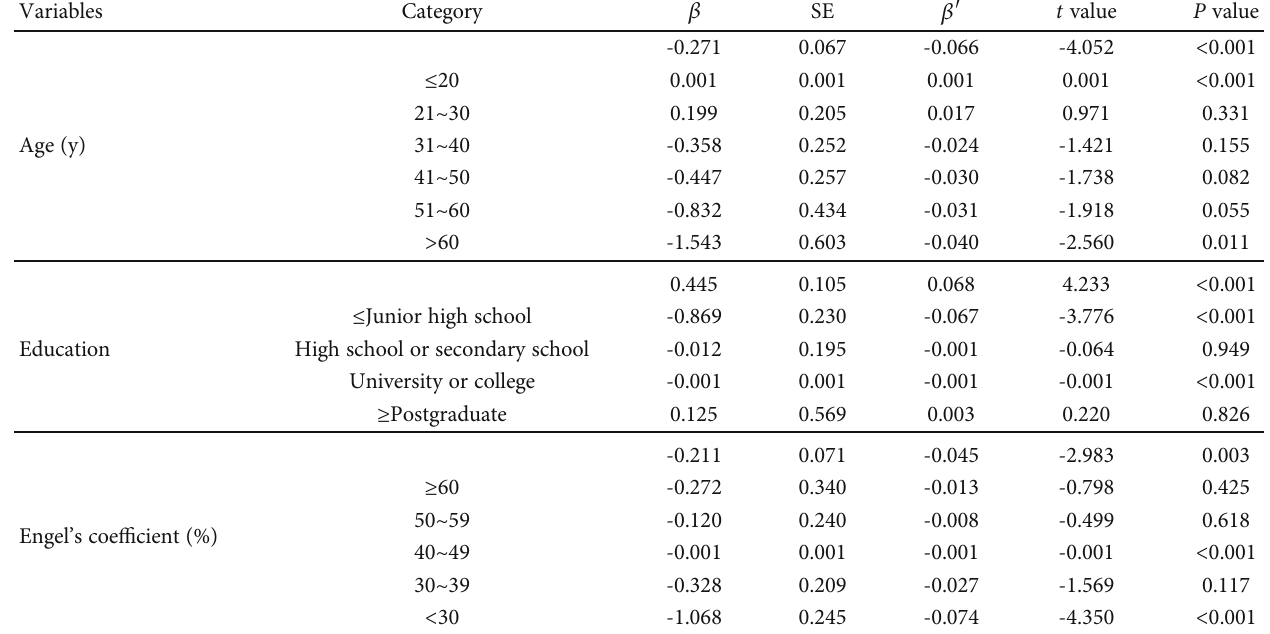
Table 3: Multiple stepwise linear regression analysis on the consumers ’ concern on dairy product label information.